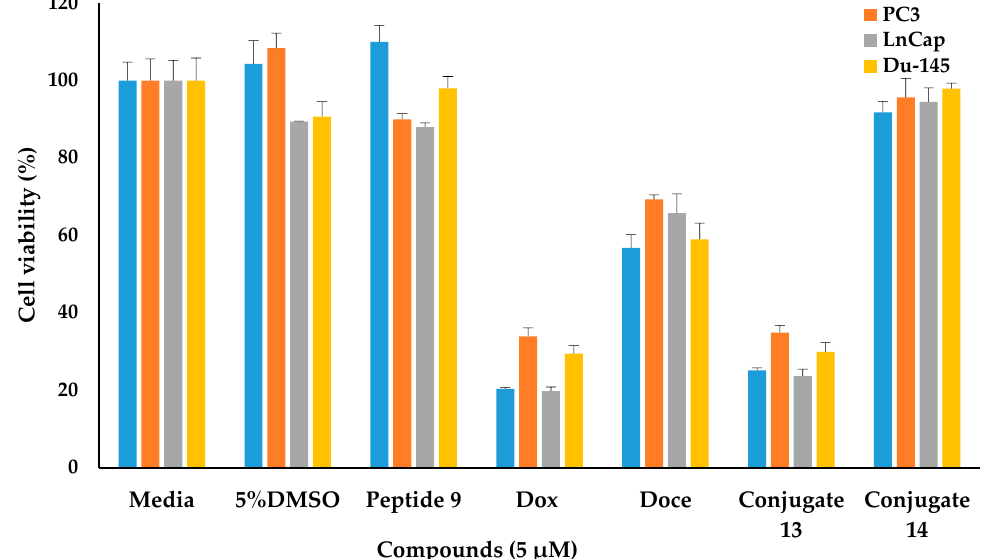
Figure 9. Cell viability of peptide 9 , Dox, Doce, Dox–peptide conjugate 13 , and Doce–peptide conjugate 14 at 5 µM on prostate epithelial and PCa cell lines (RWPE-1, PC3, LNCap, Du-145) after 72 h using MTS assay.